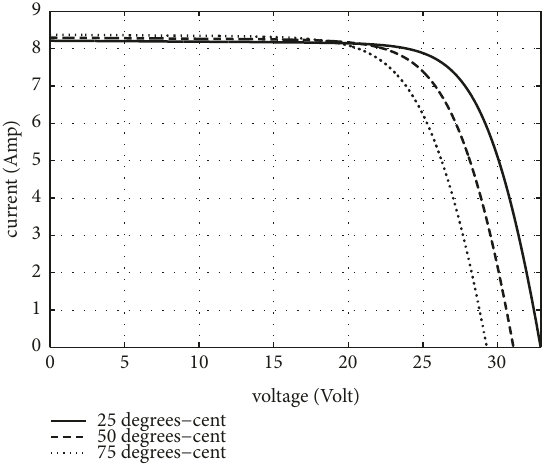
Figure 8: I–V model curves of the KC200GT solar module at different temperature, 1000W/m 2 .